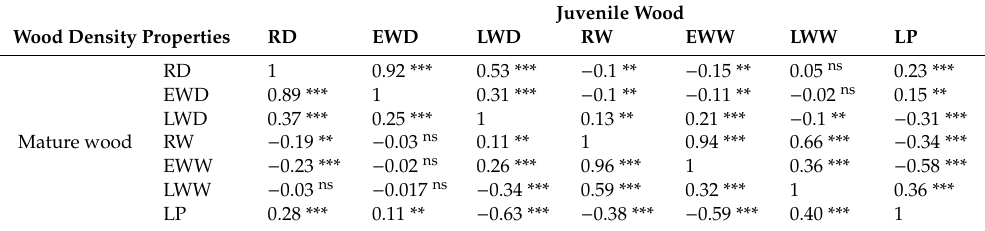
Table 4. Pearson correlation coe ffi cients between ring density components and ring widths in juvenile and mature wood of T. occidentalis and their statistical